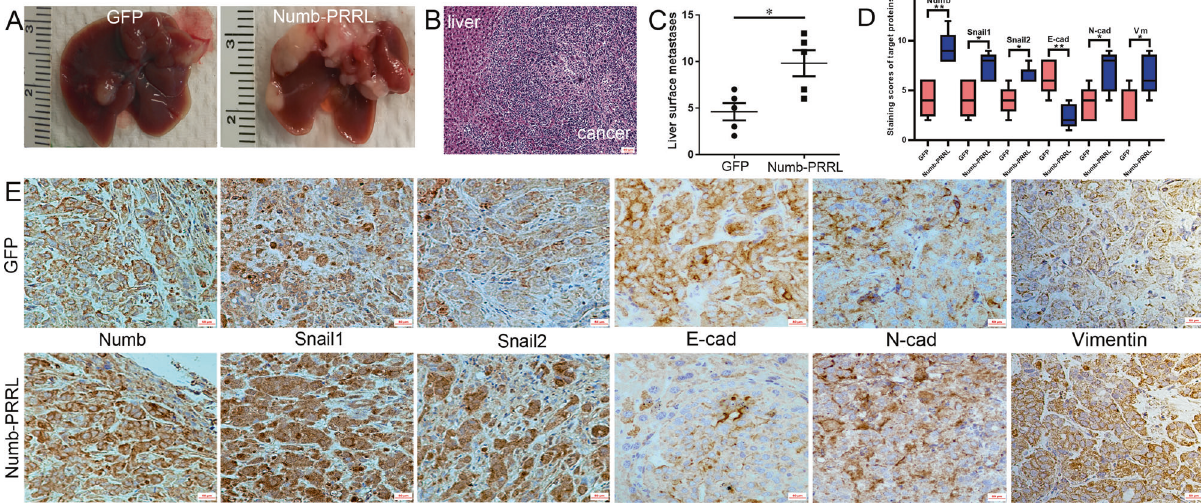
Fig. 7 Numb-PRRL overexpression promoted distant liver metastasis in vivo. A Liver metastases in the Numb-PRRL and GFP groups implanted with Miapaca-2 cells. B HE staining of harvested tumor. C The statistic data involving the number of liver metastasis in Numb-PRRL and GFP groups. D The statistic data of IHC assays. E The different expression levels of Numb, Snail1, Snail2, E-cad, N-cad, and Vimentin in Numb-PRRL and GFP groups by IHC. Bars indicate ±S.E. * P < 0.05; ** P < 0.01 compared with